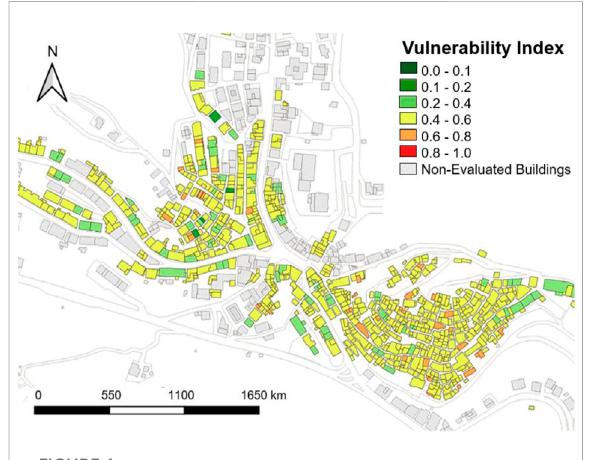
FIGURE 2 Typological vulnerability classes derived according to the EMS-98